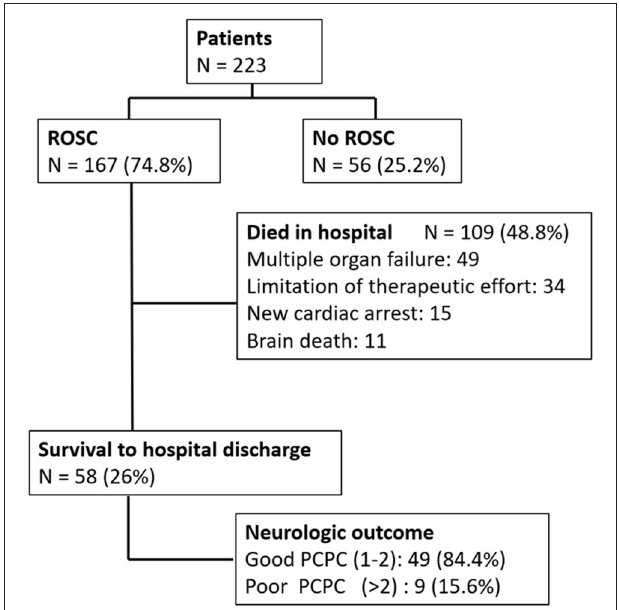
FIGURE 1 | Algorithm of in-PICU CA. ROSC, return of spontaneous circulation; PCPC, pediatric cerebral performance